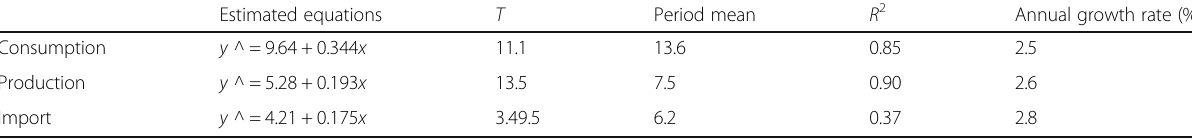
Table 2 Equations of the general trend of consumption, production, and imports of wheat during the period (1995 – 2016) Estimated